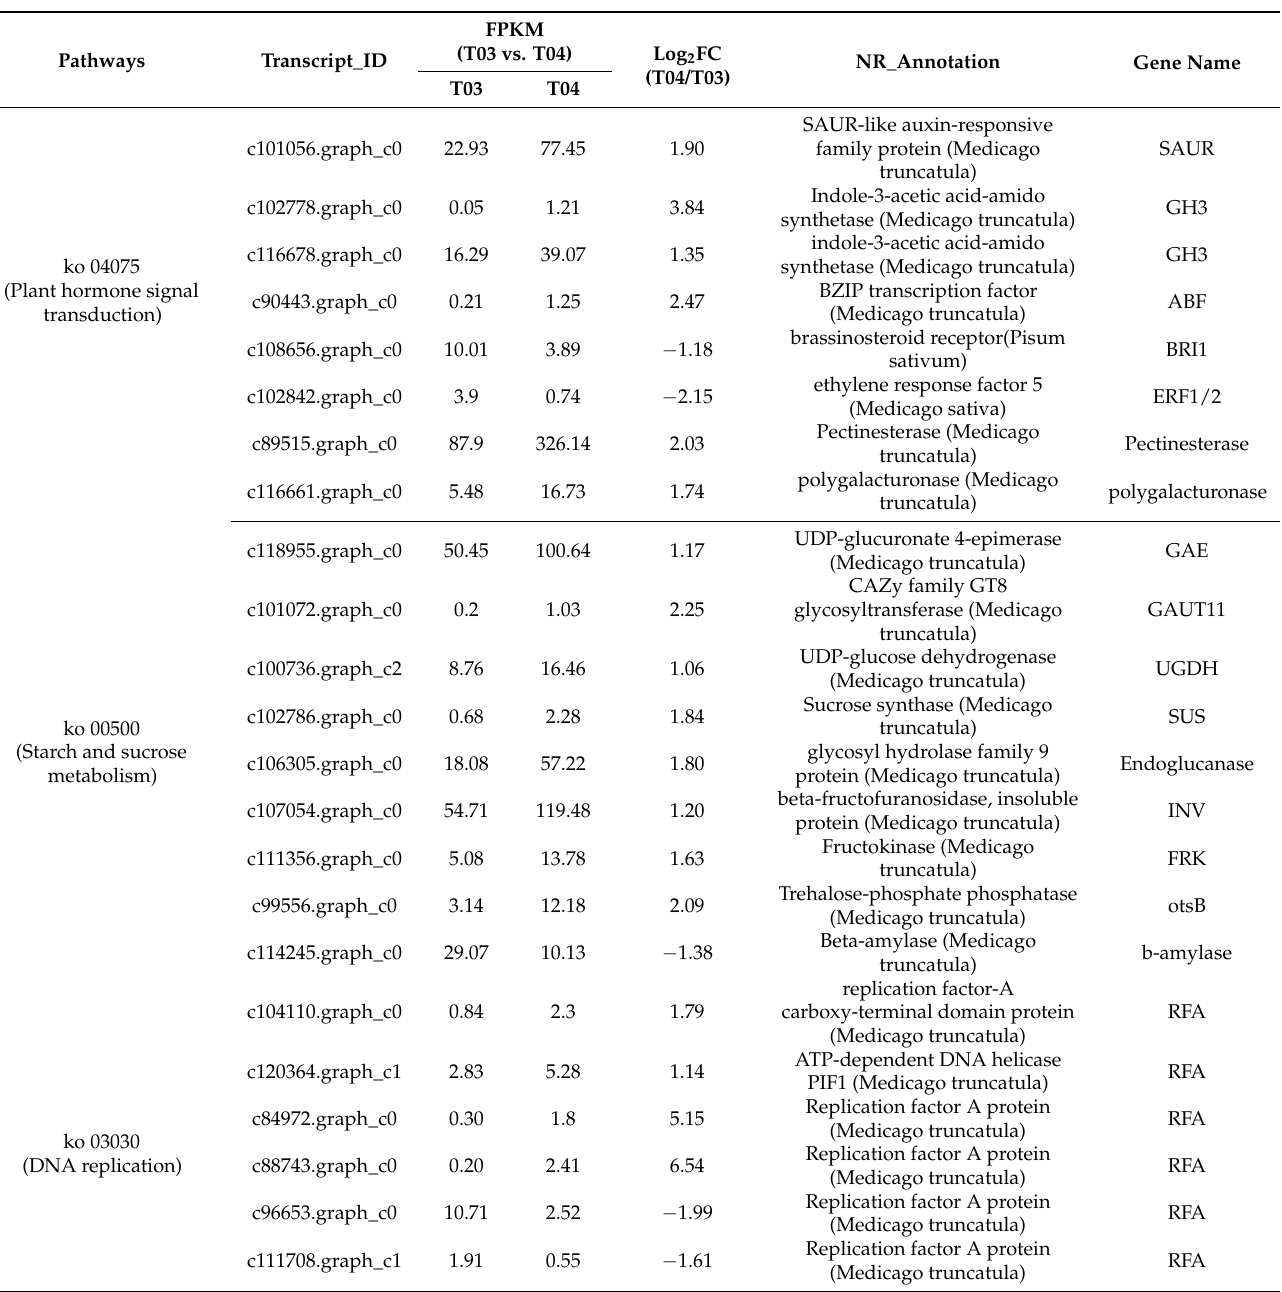
Table 4. The sterility related DEGs participating in three key